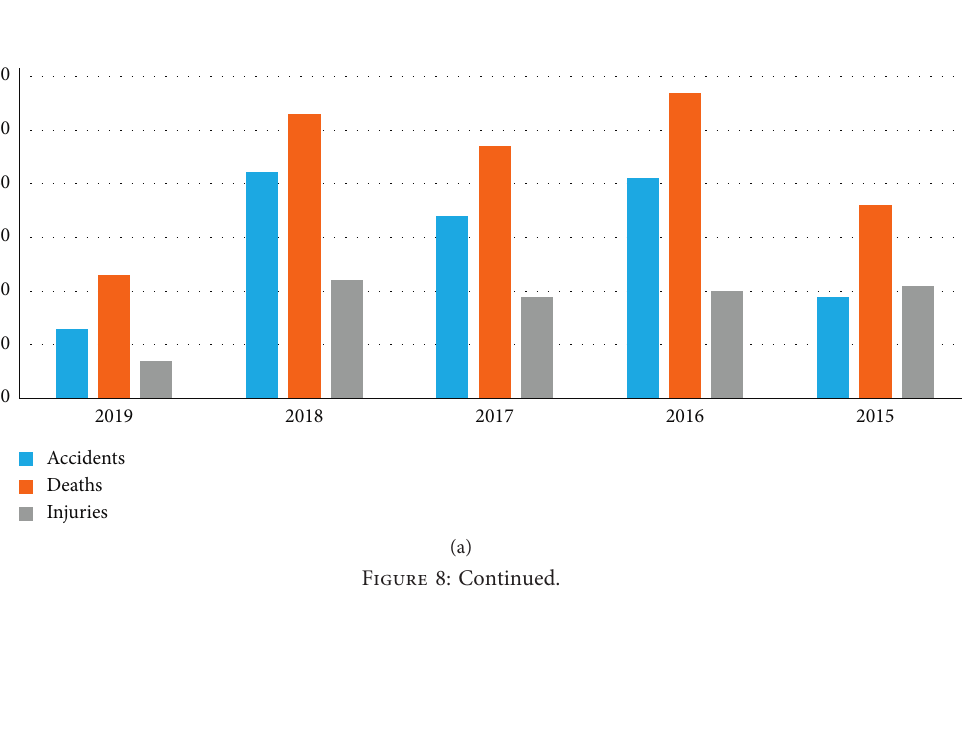
Figure 7: STAMP model in the usage phase.